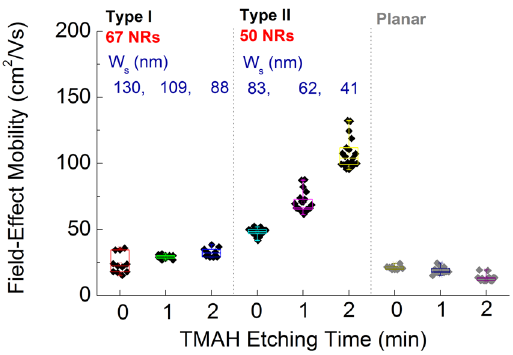
Figure 7. μ FE vs the different sizes of NRs. Higher μ FE was observed with shrinking